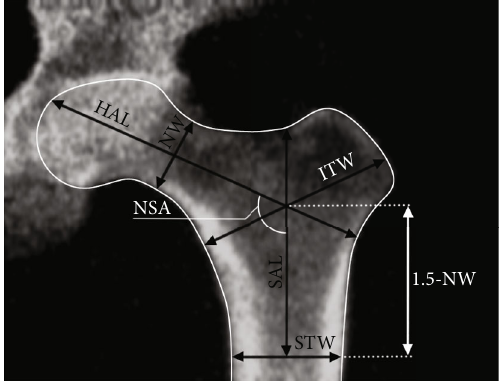
Figure 3: Graphical description of geometrical attributes